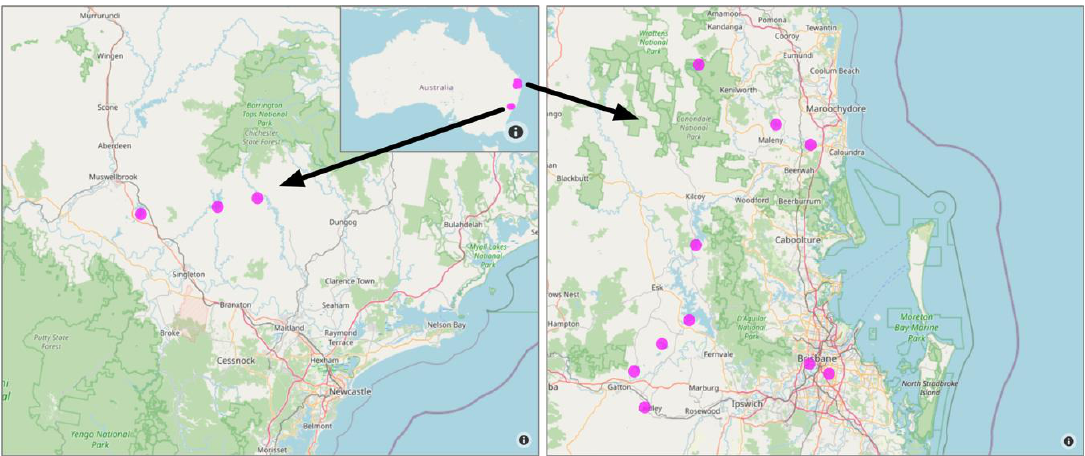
Figure 2. The locations of the 13 water bodies sampled in New South Wales and South East Queensland. Basemap courtesy of openstreetmap.org.